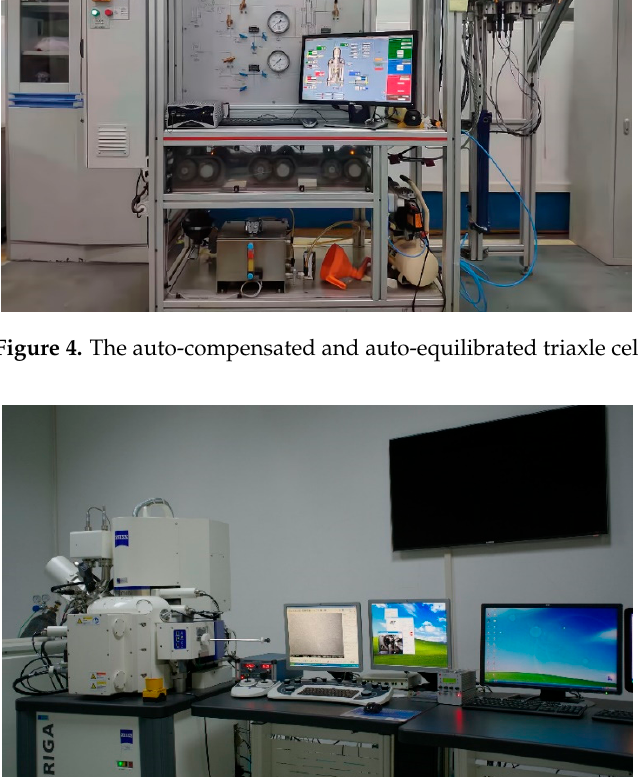
Figure 5. ZEISS Auriga SEM/FIB Crossbeam System.